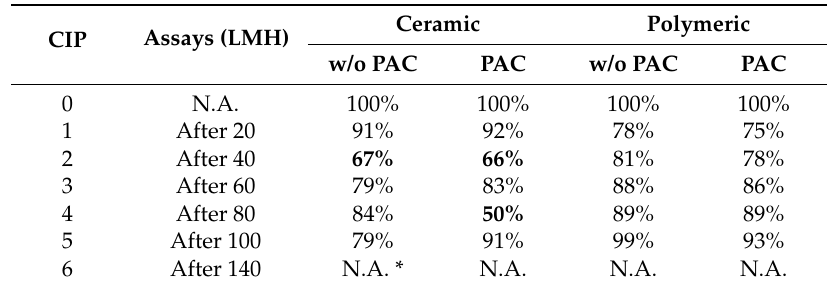
Permeability recovery (%) after the Clean-in-Place (CIP) procedure between each assay